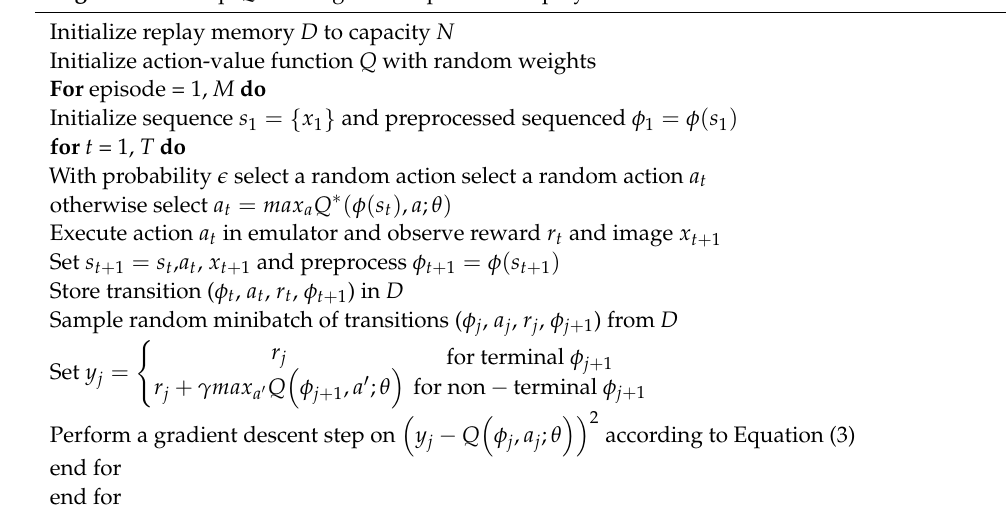
Algorithm 3 Deep Q-learning with Experience Replay